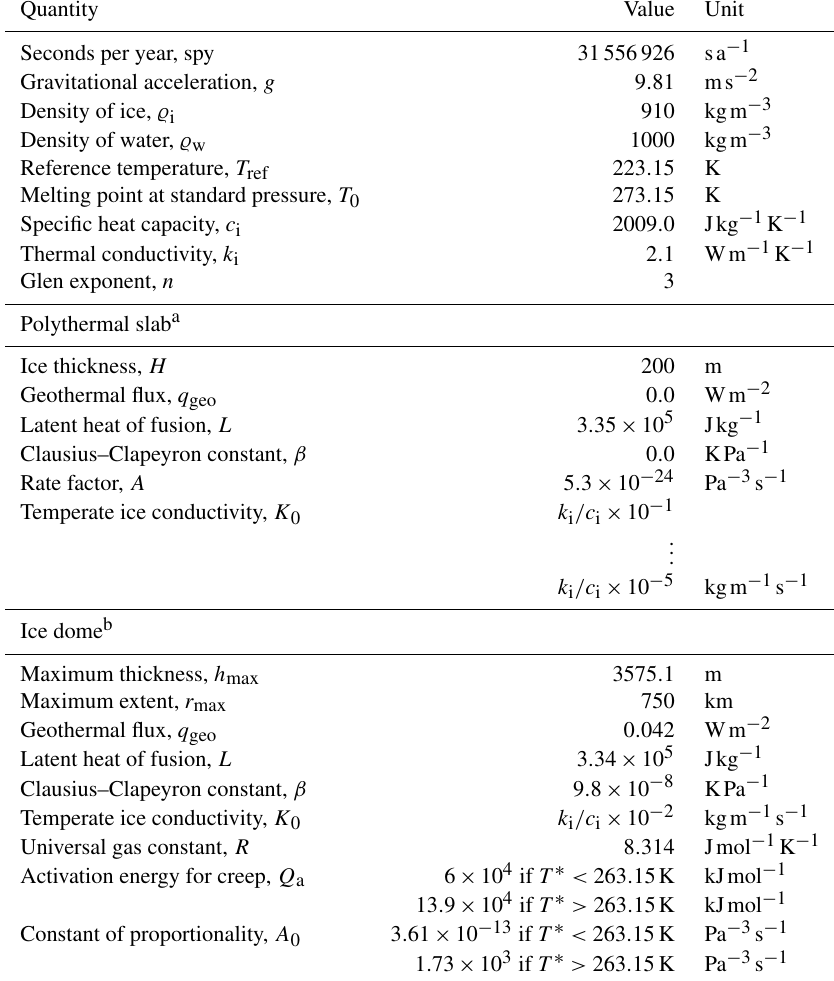
Table 1. Constants and model parameters